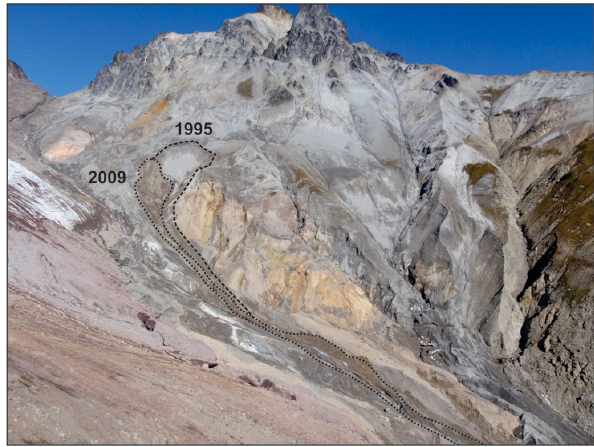
Fig. 4. Mount Meager before the 2010 landslide. The sources and upper paths of the 2009 and 1995 Mount Meager debris flows are outlined and coincide roughly with the present-day location of the lateral shear. The darker colour of the 2009 event is from groundwa- ter saturation, and the orange staining of rock on the lower slopes indicates long-term exposure to high groundwater levels and hy- drothermally altered volcanic rock (photograph by Dave